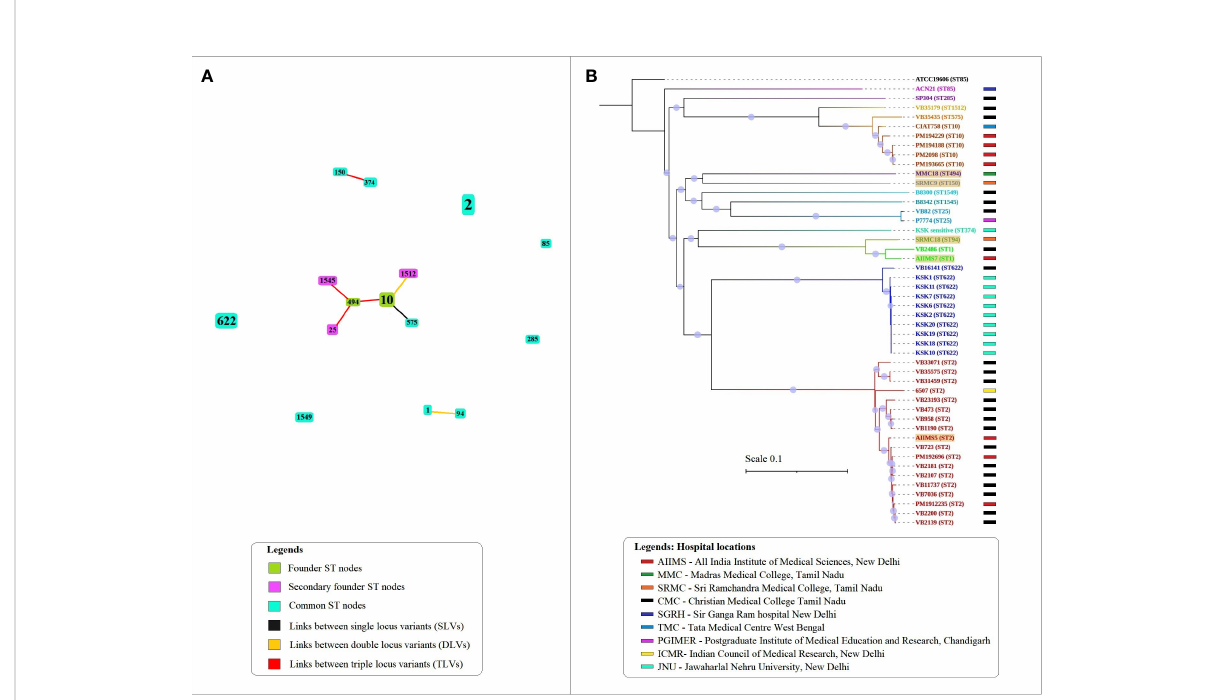
FIGURE 1 The sequence types and phylogenetic relationship between A. baumannii isolates analyzed in the study. (A) The eBURST analysis showing relationship between 15 STs detected in the population using the Pasteur scheme. The size of nodes is proportional to the number of isolates presenting that ST in the population under study. (B) The alignments of concatenated SNPs with 100 bootstrap replicates explain the phylogenetic relationship between 47 Indian A. baumannii genomes. The A. baumannii ATCC 19606 was used as the reference genome for alignment and SNP calling. The tree is rooted at reference genome. Different colors represent the grouping by sequence